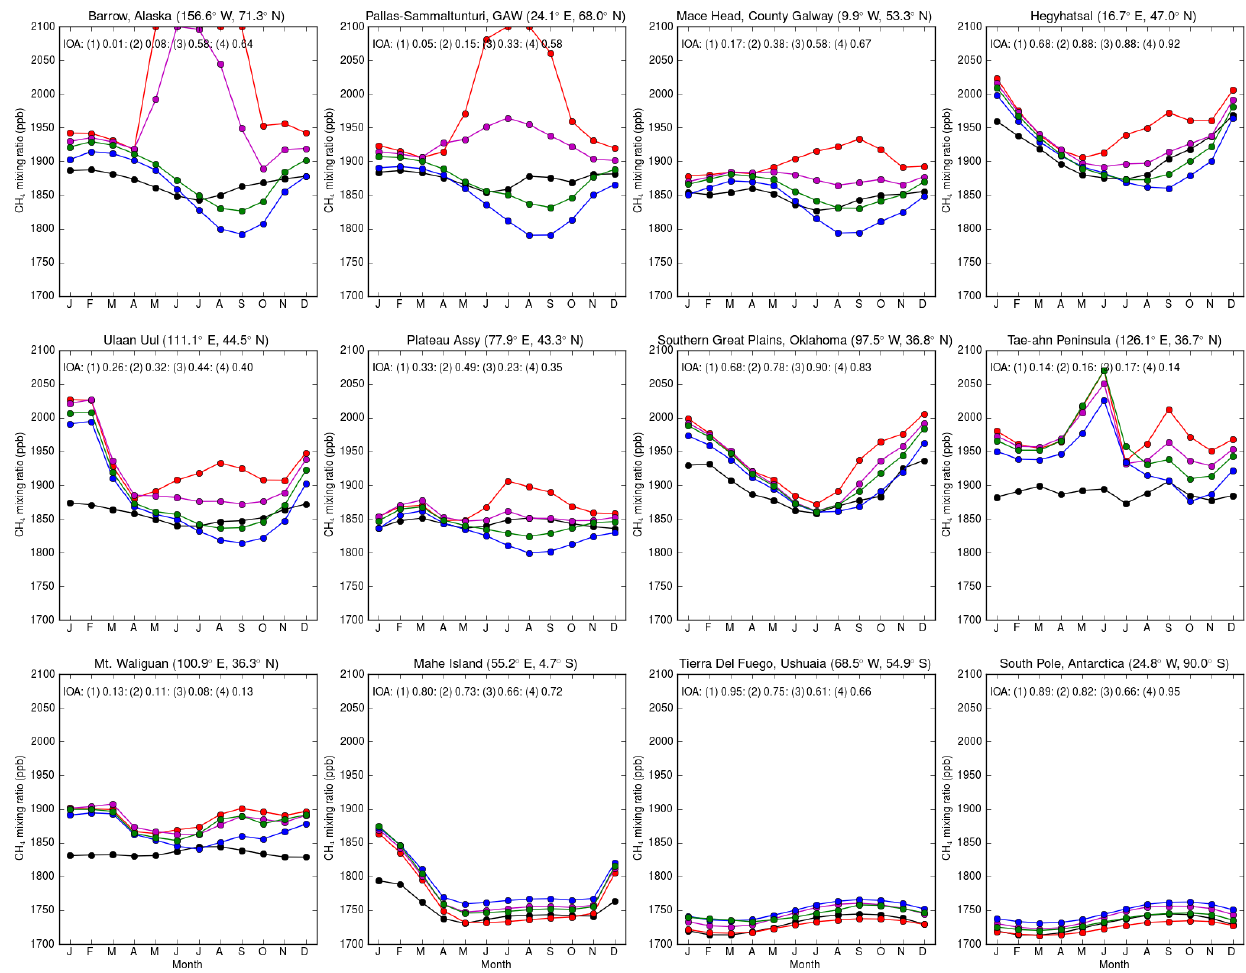
Figure 4. Comparison of the annual cycle in the surface atmospheric methane mixing ratio (in ppb) at selected sites between the years 2000 and 2010, as observed (black) and from the HadGEM2 runs using the following wetland emission inventories, (1) FUNG (red), (2) TRANSCOM-FUNG (magenta), (3) JULES (blue), and (4) JULES-GIEMS (green). The IOA is shown for each